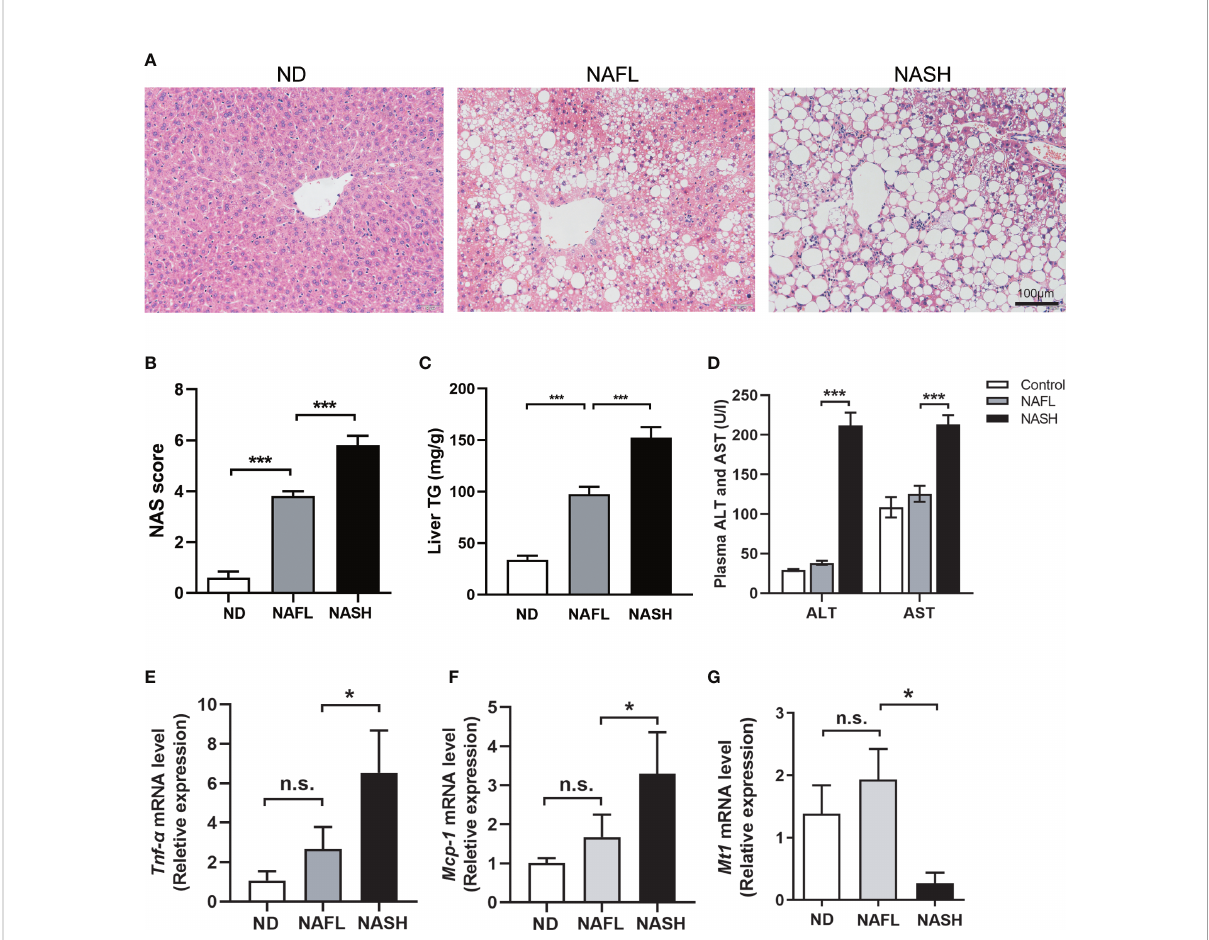
FIGURE 4 Decreased expression of Mt1 in NASH mouse model. (A) H & E staining of ND, NAFL, and NASH mice. (B) Liver TG quanti fi cation of ND, NAFL, and NASH mice. (C) NAS score assessed in H&E-stained liver sections. (D) Serum ALT and AST of three groups of mice. (E, F) Expression of Tnf a and Mcp1 measured by RT-PCR from ND, NAFL, and NASH mice. (G) Expression of Mt1 measured by RT-PCR from ND, NAFL, and NASH mice. The expression level of genes was standardized by ND group in (D, E) N = 5 mice per group, and all data are shown as mean ± SEM. * p < 0.05, *** p < 0.001. “ n.s. ” means no signi fi cance. TG, triglyceride; NASH, non-alcoholic steatohepatitis; ND, normal diet; NAFL, non-alcoholic fatty liver; NAS, non-alcoholic fatty liver disease activity score; ALT, alanine transaminase; AST, aspartate